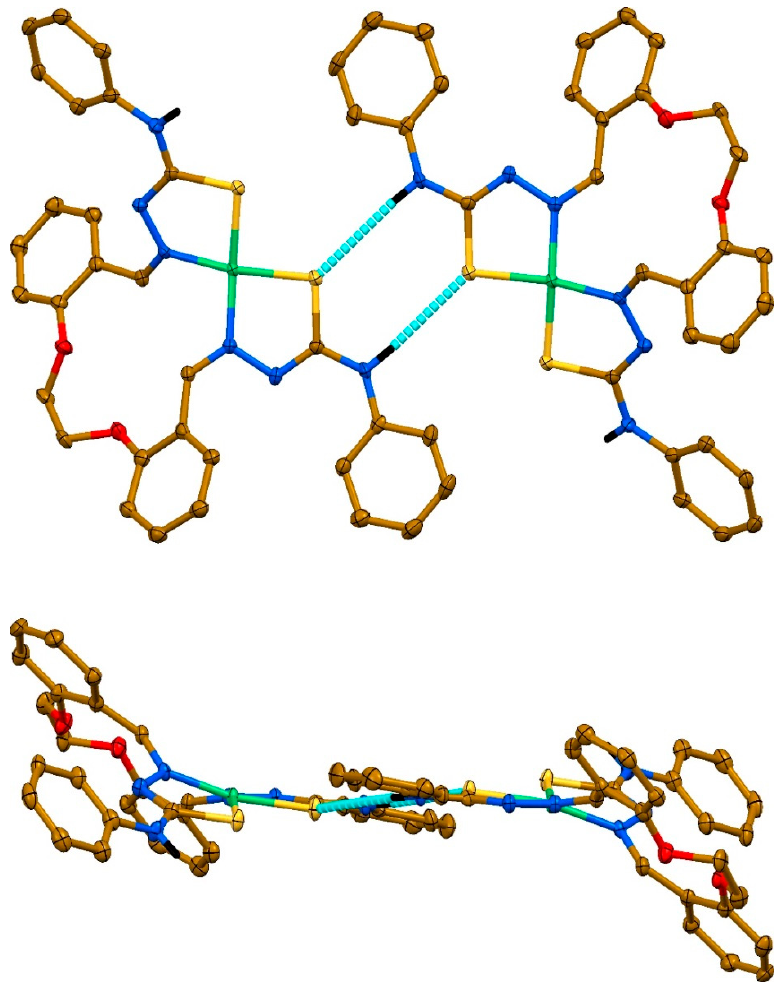
Figure 1. Top and side views on the hydrogen bonded centrosymmetric dimer in the crystal structure of 1 , formed by a pair of molecules 1-I (ellipsoids are drawn with 40% probability; CH hydrogen atoms are omitted for clarity). A similar centrosymmetric dimer is also formed by a pair of molecules 1-II . Color code: C = gold, H = black, N = blue, O = red, S = yellow, Ni = green; N–H ∙∙∙ S hydrogen bond = cyan dashed line. Table 1. Selected Bond Lengths (Å) and Angles (°) for 1 and 2 .